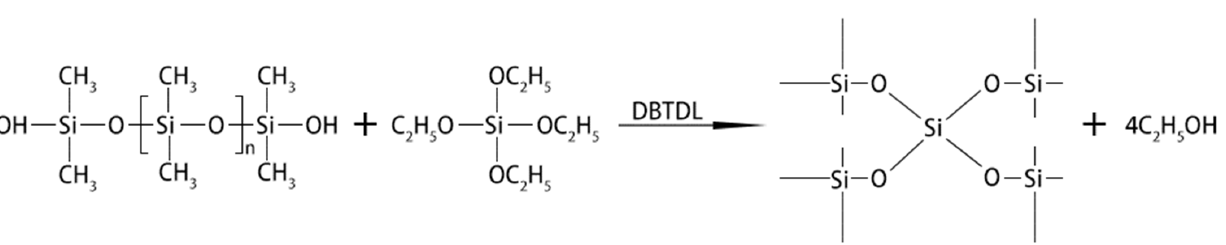
Figure 4. FTIR spectra of coating C and RTV silicone. 3.4. Anti ‐ Corrosion Performance Corrosion resistance is one of the important characteristics of the superhydrophobic surface. Electrochemical impedance spectroscopy (EIS) is used to compare the difference between polished copper foil and copper foil with a superhydrophobic coating [29,30]. Referring to the test method of Zhu et al. [31], using an electrochemical workstation (CS2350H, Wuhan CorrTest Instruments Corp., Ltd., Wuhan, China), at room temperature, through a standard three ‐ electrode system, the corrosion behavior of different samples in 3.5 wt.% NaCl aqueous solution was tested. It can be seen from the Nyquist spectra, that the radius of the capacitive reactance arc of the superhydrophobic coating is much larger than that of the bare copper (Figure 5a). The larger the radius of the capacitive reactance arc is, the greater the resistance is in the process of charge transfer. As shown in Figure 5b, the Bode spectra provides further evidence. The | Z | value of the superhydrophobic coating is eight orders of magnitude larger than that of the bare copper. To explain the corrosion resistance of the coating more intuitively, Table 2 shows the values of the components corresponding to the equivalent circuit diagram obtained by the fitting software (ZView 2, Solartron, West Sussex, UK), according to the equivalent circuit diagram in Figure 5c. CPE 1 and CPE 2 are artificially assumed to be alternatives for pure capacitive elements, and they are used to improve the results of the fitting. When the dimensionless index n is equal to 1, the constant phase angle element is pure capacitance. R s and R 1 / R 2 are solution resistance and charge transfer resistance, respectively. As shown